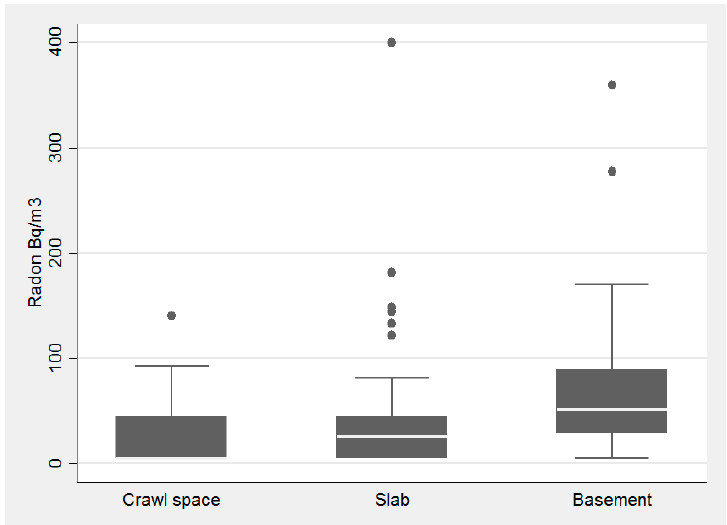
Figure 5. Association with foundation type and radon concentration in the pilot study of homes tested in DeKalb County in 2015.